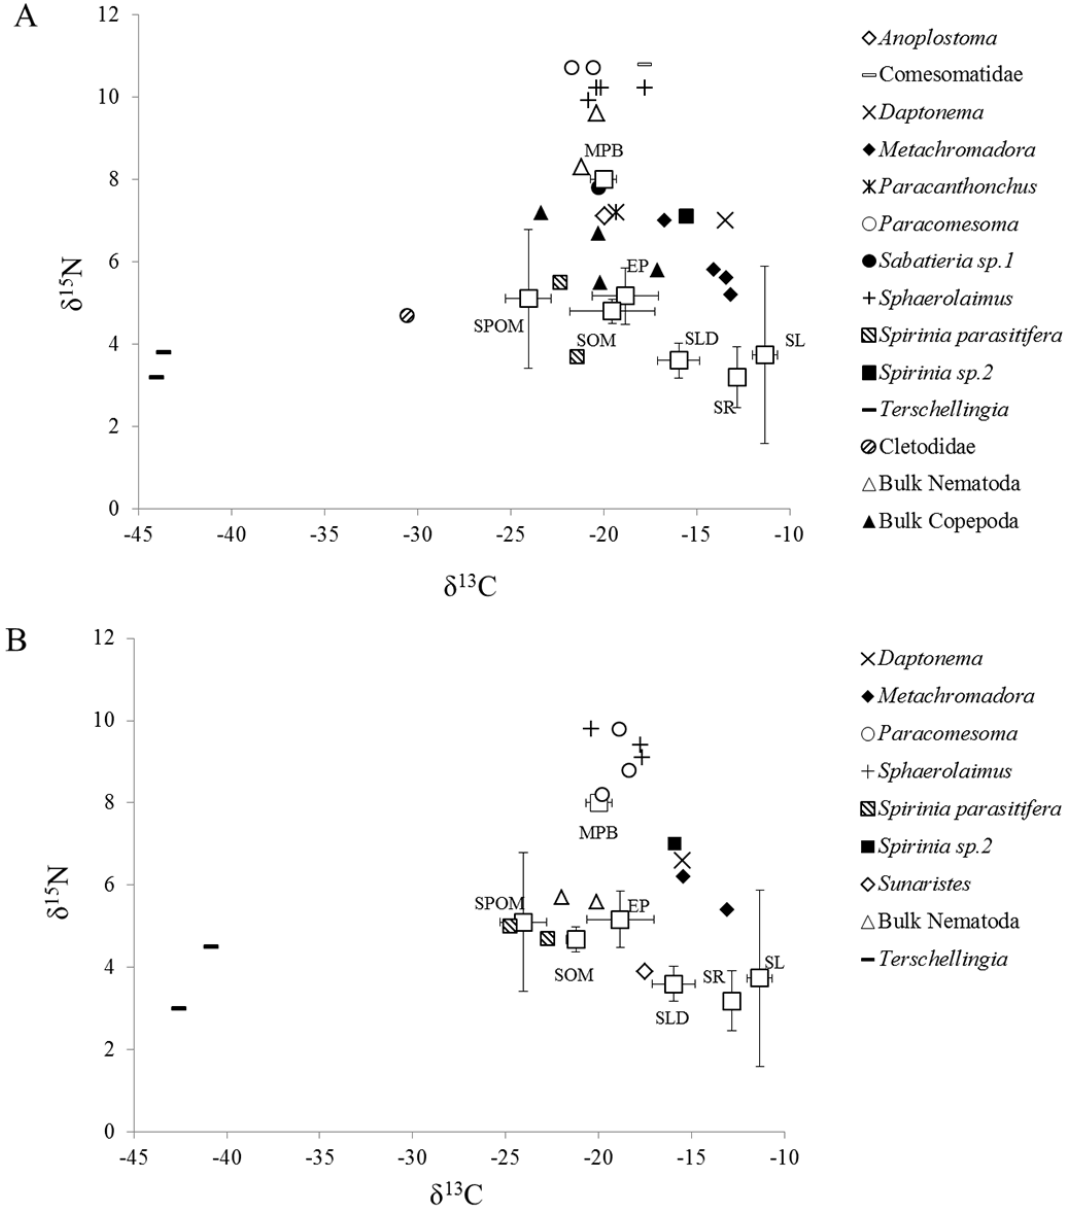
Figure 3. Biplots of δ 13 C /δ 15 N of meiobenthos from the upper 2cm and their potential resources in seagrass beds (A) and bare sediments (B) . Resource data are mean values ( ± SD) of all replicate samples per source material. Abbreviations used: SL, SR and SLD for seagrass leaves, roots and detritus, respectively; EP for epiphytes, MPB for microphytobenthos, SPOM for suspended particulate organic matter and SOM for bulk sediment organic